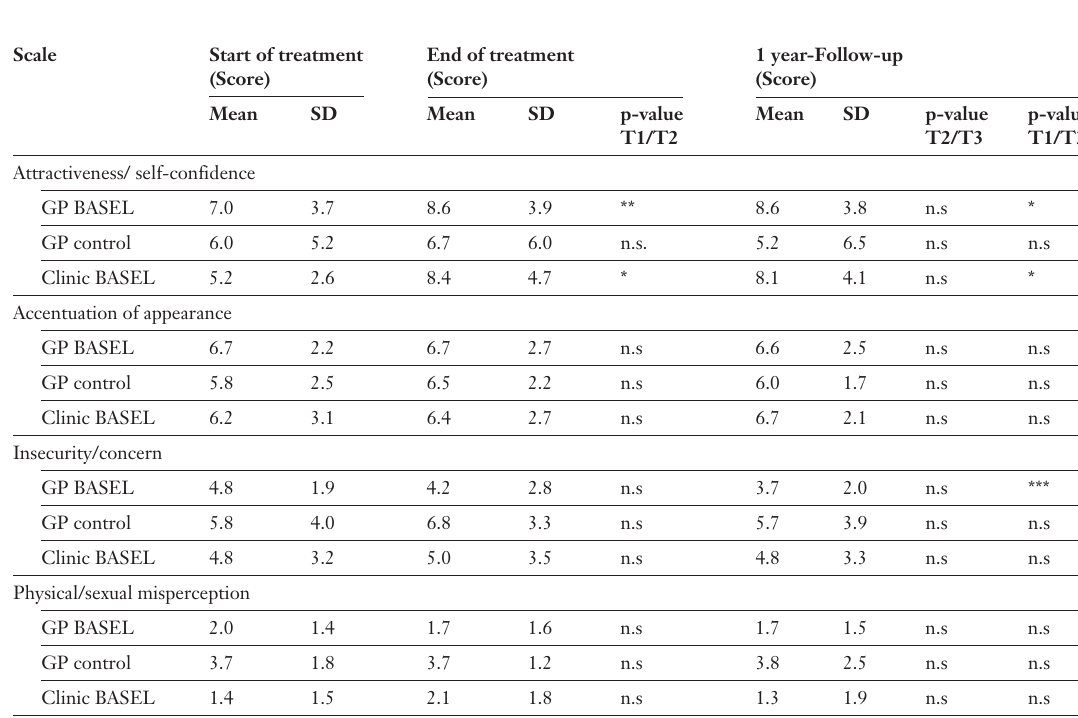
Questionnaires of body image (FBeK;